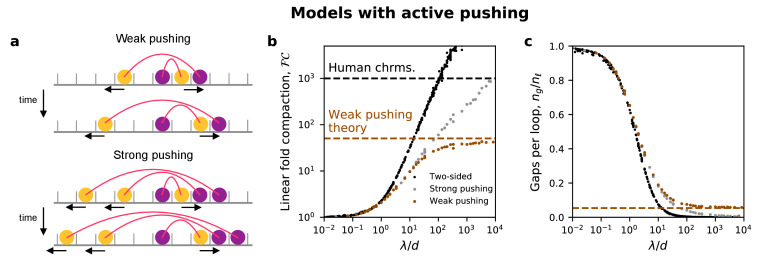
Models in which the active subunits of nested LEFs can push passive LEF subunits.(a) Cartoon arch diagrams of ‘weak’ and ‘strong’ pushing models (top two and bottom two panels, respectively). One-sided LEFs are composed of active subunits (yellow) connected to passive subunits (purple); active subunits translocate in the direction indicated by the arrow along the chromatin polymer (gray), shown as a series of discrete sites. In the weak pushing model, an active LEF subunit can only push a single passive LEF subunit. In the strong pushing model, an active LEF subunit can simultaneously push multiple consecutive passive LEF subunits. See Appendix 1 for more details. (b) Fold linear compaction shown for the two-sided model (black), the strong pushing model (gray), and the weak pushing model (brown). Purple and brown dashed lines indicate large λ/d predictions from mean-field theory for one-sided and weak pushing models, respectively. (c) Number of gaps per loop for the two-sided, strong pushing model, and weak pushing models, with the brown dashed line showing the mean-field prediction for the weak pushing model.